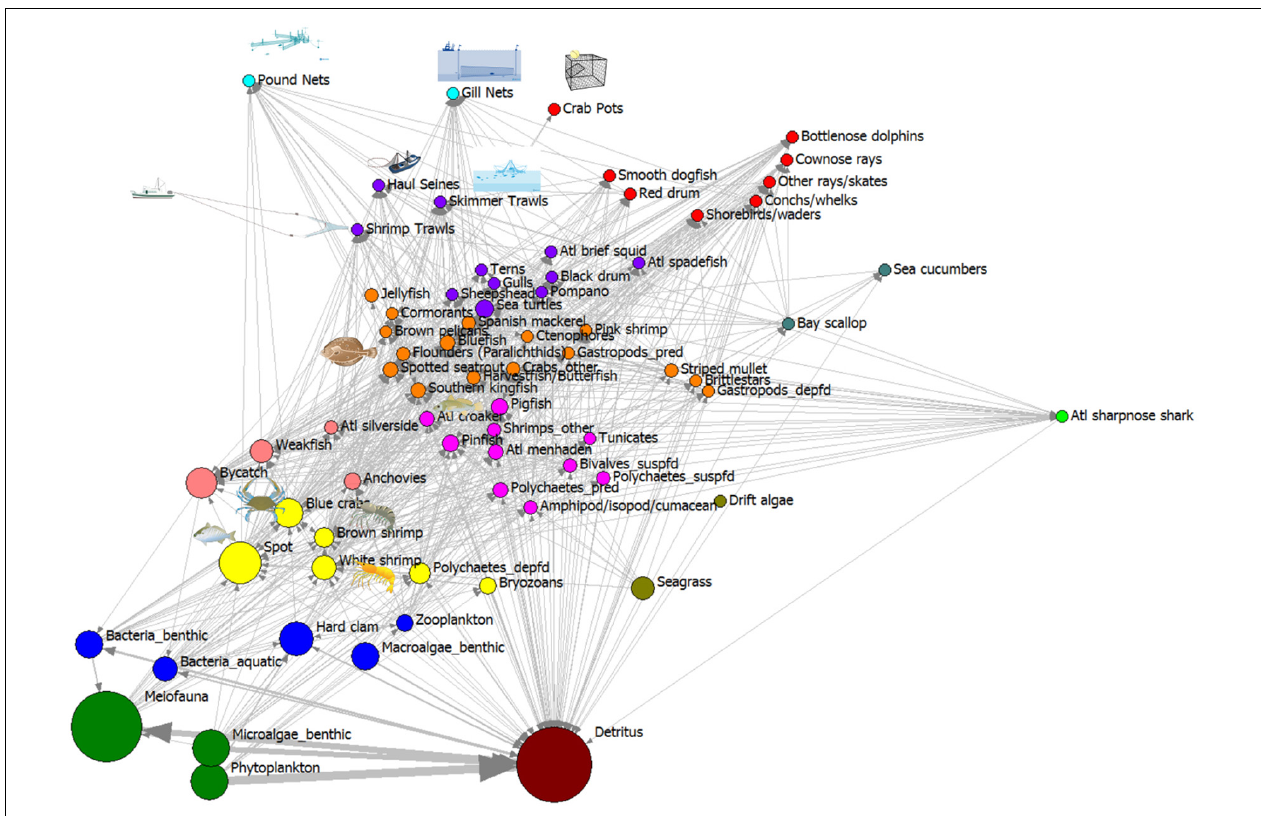
FIGURE 5 | Trophic roles revealed using regular equivalence similarity measure non-metric MDS plot of Core Sound network model of the areas open to shrimp trawling in fall (2006–2007 NCDMF data). Node size proportional to log 10 (g C biomass/m 2 ). Color code for nodes in these isotrophic classes: (1) brown: detritus and particulate organic carbon; (2) green: phytoplankton, benthic microalgae, benthic meiofauna; (3) blue: benthic bacteria, aquatic bacterioplankton, benthic macroalgae, hard clams, zooplankton; (4) light green: seagrasses, drift algae; (5) yellow: various invertebrates that consume meiofauna and detritus (bryozoans, deposit-feeding polychaetes, white and brown shrimp, blue crabs), fish (spot); (6) magenta: invertebrates (amphipods, isopods, cumaceans, predatory and suspension-feeding polychaetes, shrimps, tunicates), fishes (Atlantic croaker, pinfish, pigfish, Atlantic menhaden); (7) pink: bycatch, anchovies; weakfish, Atlantic silversides; (8) orange: invertebrates (jellyfish, ctenophores, deposit-feeding gastropods, predatory gastropods, brittlestars, pink shrimp, crabs), fishes (striped mullet, southern kingfish, spotted seatrout, weakfish, harvestfish/butterfish, paralichthyid flounders, bluefish, Spanish mackerel and birds (cormorants, gulls, brown pelicans); (9) purple: top predators group A, invertebrates (Atlantic brief squid), fishes (sheepshead, Florida pompano, black drum, Atlantic spadefish), birds (terns, gulls), sea turtles, and fishery gears (shrimp trawls, skimmer trawls, and haul seines); (10) red: top predators group B: invertebrates (conchs and whelks), fishes (red drum, cownose rays, other rays and skates, smooth dogfish); birds (shorebirds/waders), marine mammals (bottlenose dolphins); and the fishery gear (crab pots); (11) dark blue-green (bay scallops, sea cucumbers); (12) lime green: Atlantic sharpnose sharks; (13) cyan: pound nets and gill